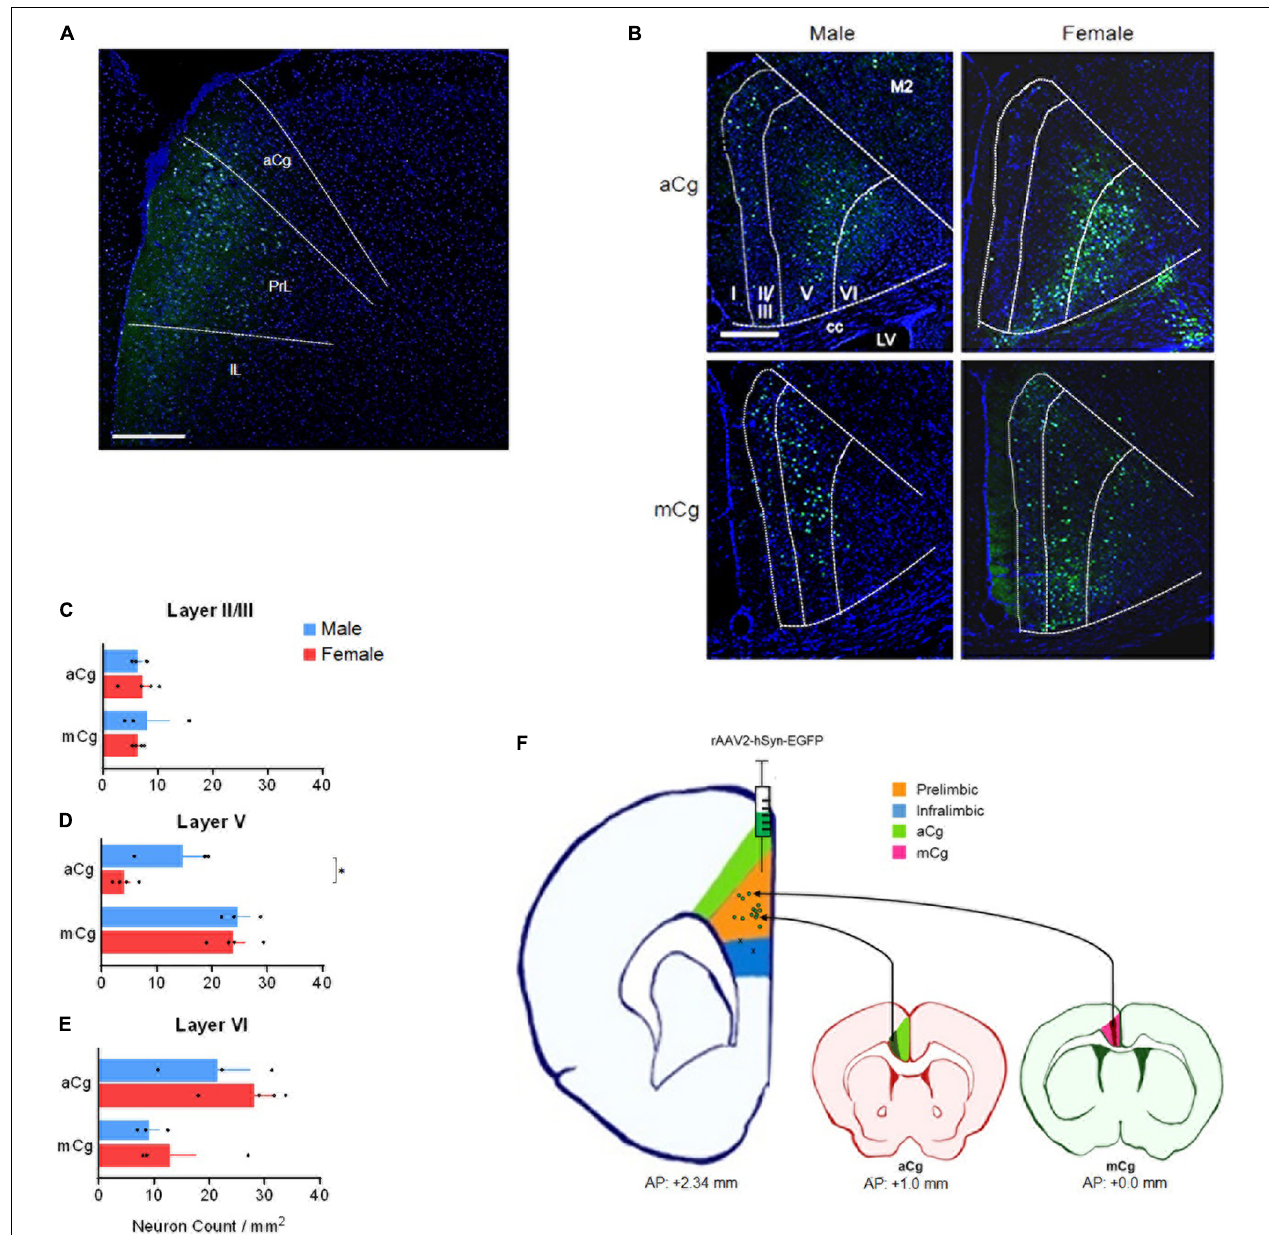
FIGURE 2 | Laminar distribution of aCg/mCg → PrL neurons, in male and female mice. (A) Representative image identifying the injection sites in the prelimbic cortex (antero-posterior from bregma, +2.34 mm; mediolateral from bregma, +0.35 mm; dorso-ventral from dura, –1.95 mm) (Franklin and Paxinos, 2013) of an adult C57BL/6J mouse. The final titer of the virus was 7 × 10 12 viral particles per ml. aCg, anterior cingulate cortex; PrL, prelimbic cortex; IL, infralimbic cortex. Scale bar = 500 µ m. (B) Representative images of the aCg and mCg from C57BL/6J male and female mice. EGFP-labeled neurons in aCg and mCg were observed ipsilateral to the virus injection site of PrL. A smaller proportion of neuronal labeling on the contralateral side was also observed. DAPI was used as counter-staining. M2, motor cortex; cc, corpus callosum; LV, lateral ventricle. Scale bar = 500 µ m. (C) Counting of aCg/mCg → PrL projections located in layers II/III. Two-way ANOVA for interaction: F 3 , 10 = 0.036, p = 0.852; main effect for brain area: F 1 , 10 = 0.038, p = 0.850; main effect for sex: F 3 , 10 = 0.026, p = 0.874. (D) Counting of aCg/mCg → PrL projections located in layer V. Two-way ANOVA for interaction: F 3 , 10 = 3.804, p = 0.080; main effect for brain area: F 1 , 10 = 37.114, p < 0.001; main effect for sex: F 1 , 10 = 5.511, p = 0.041. Bonferroni: aCg Female × Male, p = 0.012. (E) Counting of aCg/mCg → PrL projections located in layer VI. Two-way ANOVA for interaction: F 3 , 10 = 0.126, p = 0.730; main effect for brain area: F 1 , 10 = 9.932, p = 0.010; main effect for sex: F 1 , 10 = 1.398, p = 0.264. n = 6 for males ( n = 3 for aCg, n = 3 for mCg), n = 8 for females ( n = 4 for aCg, n = 4 for mCg). All data are presented as mean ± SEM, each dot represent the value of one individual animal. ∗ p < 0.05. (F) Injection sites in the PrL (green dots in the orange shade). Two animals were excluded from the analysis because they were injected into the infralimbic cortex (x in the blue shade). Projections from aCg originated mostly from layer VI (dark green shade), and those from mCg originated mainly from layer V (dark red